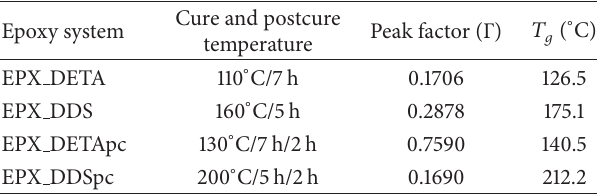
Table 2: Cure and postcure temperature peak factor and the glass transition temperature 𝑇 𝑔 for different epoxy